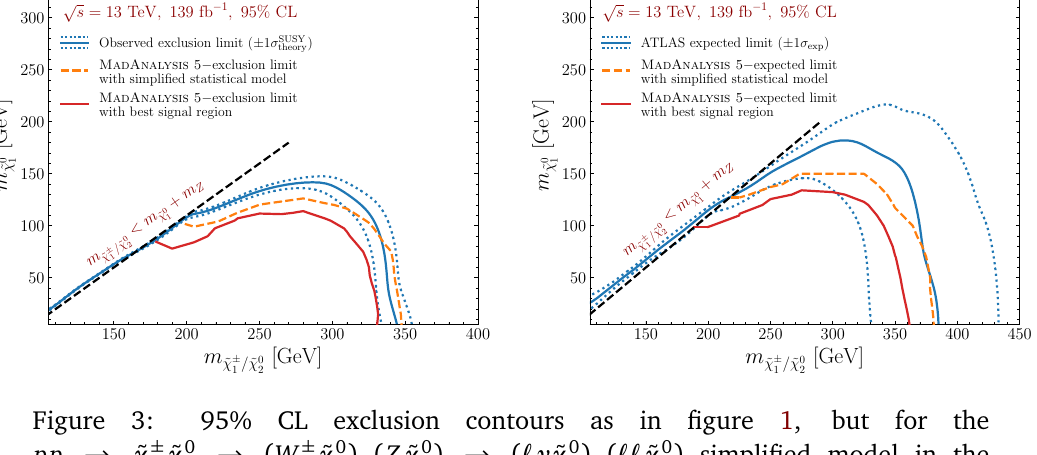
Figure 3: 95% CL exclusion contours as in figure 1, but for the → ( W ± ˜ χ 0 ) ( Z ˜ χ 0 ) → ( ℓν ˜ χ 0 ) ( ℓℓ ˜ χ 0 ) simplified model in the pp → ˜ χ ± ˜ χ 0 2 1 1 1 1 1